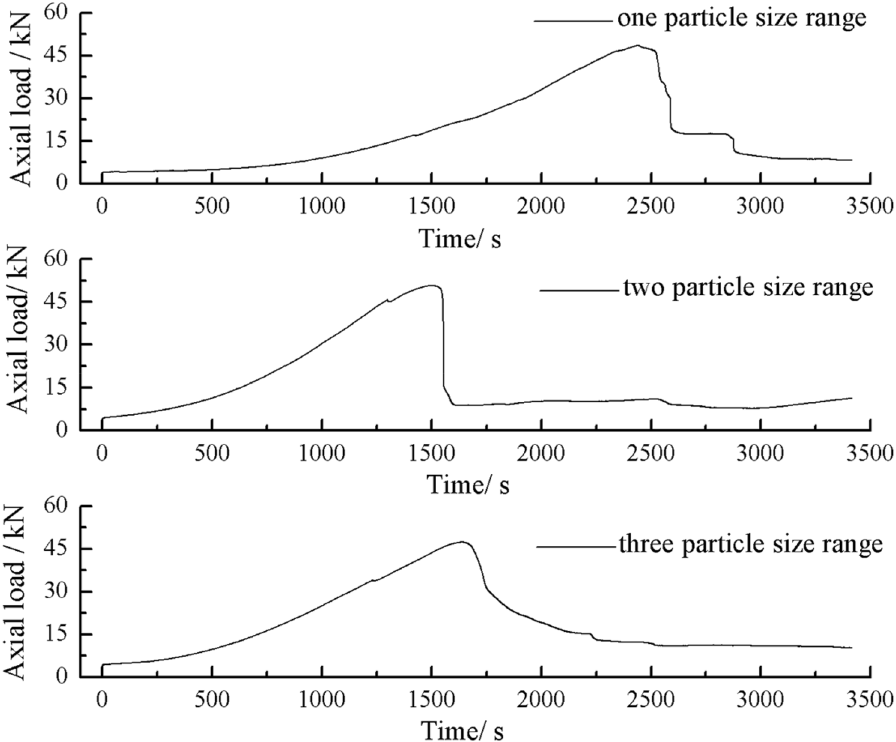
Figure 61. Axial load–Time curves for specimens containing three types of particle size ranges.